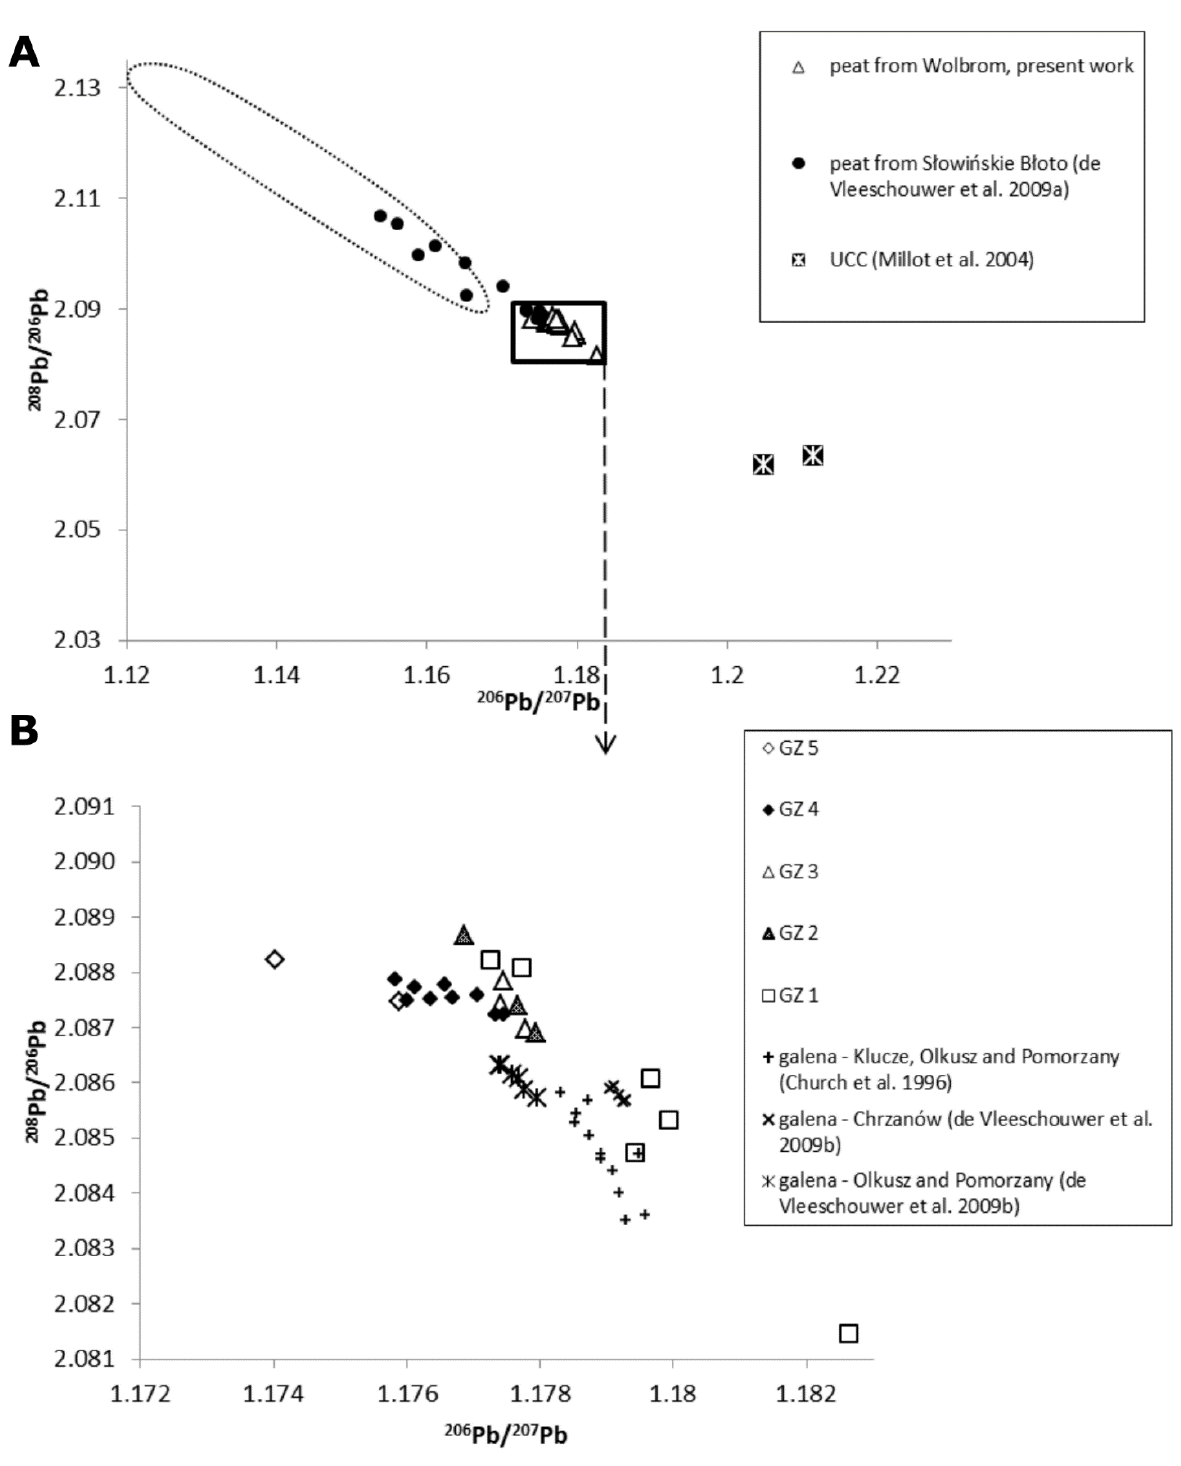
Figure 4. 208 Pb/ 206 Pb versus 206 Pb/ 207 Pb diagrams. (A) shows 24 peat samples from Wolbrom (this work), 12 peat samples from Słowińskie Błoto (De Vleeschouwer et al . 2009a), modern urban airborne particles from Europe (Bollhöfer & Rosman 2001) - marked with a dotted line, and Upper Continental Crust (UCC) (Millot et al . 2004). (B) shows the peat samples from Wolbrom, distinguished on the basis of geochemical zones (GZ 1–5), set against the background of local galena ore samples: 9 from Klucze (the nearest location to Wolbrom), 2 from Olkusz and 1 from Pomorzany (Church et al . 1996); and 5 from Chrzanów, 4 from Pomorzany and 2 from Olkusz (De Vleeschouwer et al . 2009b). The error bars are